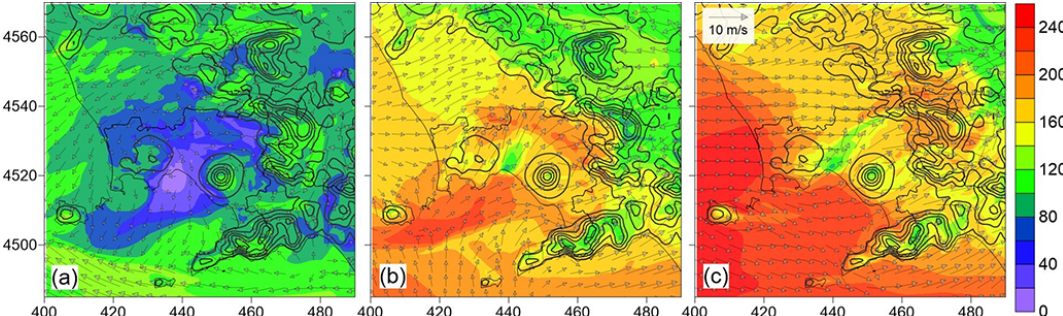
Figure 13. Near-surface ozone concentrations (µgm − 3 ) predicted for 15 July 2015 at (a) 08:00, (b) 12:00, and (c) 17:00LST over Naples. Wind field at 10m height is represented by grey arrows. (Finardi et al., 2018; ©American Meteorological Society. Used with permission.)